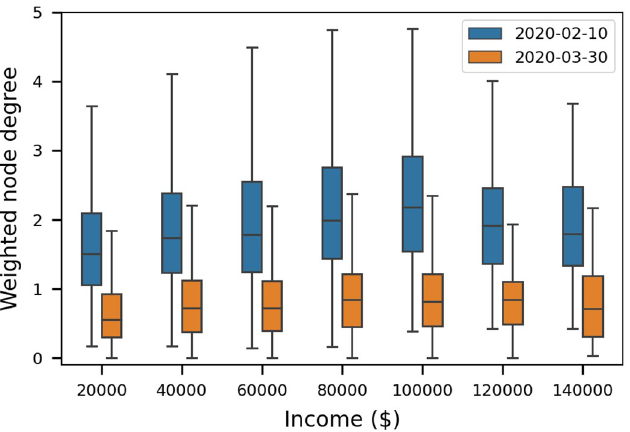
Fig 8. Weighted node degree by income bracket. Weighted node degree for February 10th and March 30th. Each income bracket ($20,000 increments) is labeled with the max value.